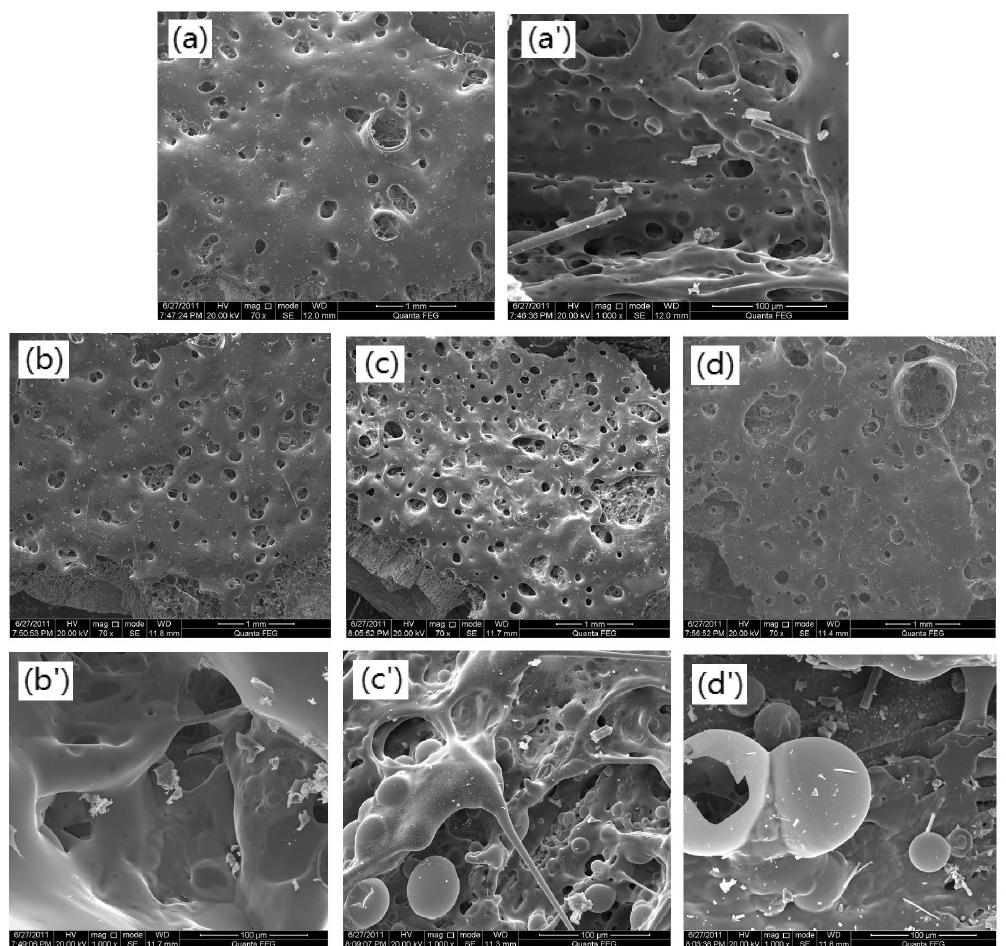
Figure 2. SEM images of the ablation surfaces of different composites (a–d: 70× magnification; a' – d' : 1000× magnification); matrices are neat phenolic resin (PR) ( a and a' ); GPSD-PR ( b and b' ); MPS-PR ( c and c' ); and GPS-MPS-PR ( d and d'